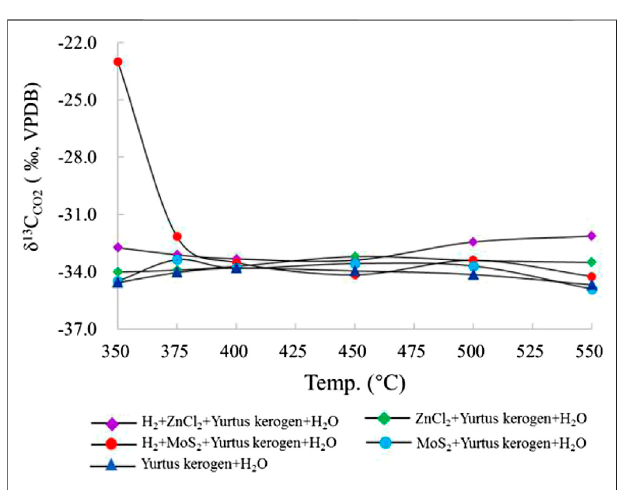
FIGURE 7 | Change in δ 13 CO 2 simulated under different catalytic hydrogenation control conditions of the closed